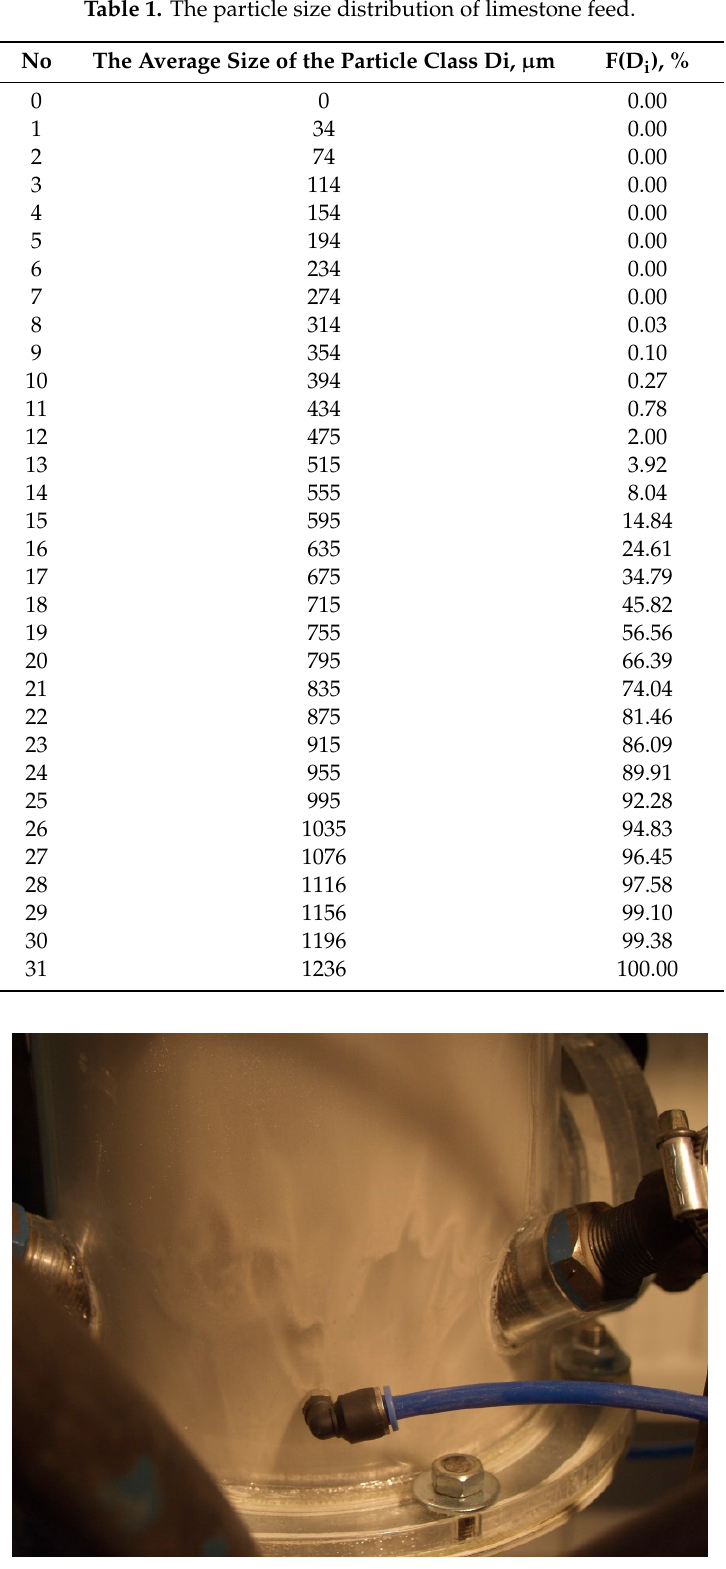
Figure 3. View of the fluidized bed in the mill chamber.